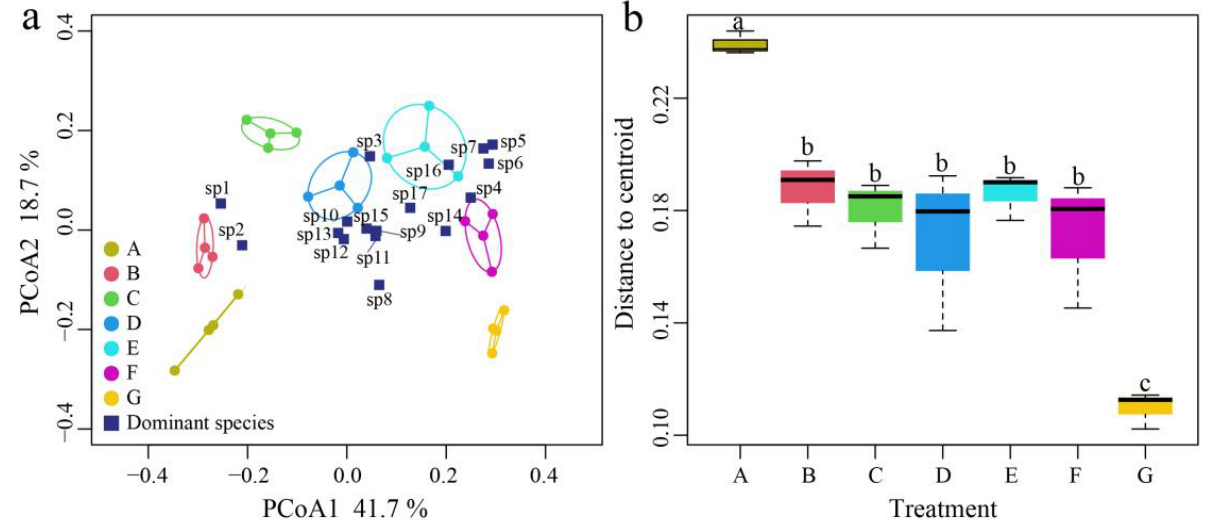
Figure 6. PcoA showed the differences in zooplankton community structure ( a ) and average dis- tance to the centroid ( b ) in the treatments of the nutrient addition experiment. Different letters rep- resent significant differences ( p < 0.05). sp1, Trichocerca stylata ; sp2, Colurella obtusa ; sp3, Polyarthra dolichoptera ; sp4, Brachionus falcatus ; sp5, B. urceus ; sp6, B. forficula ; sp7, B. angularis ; sp8, B. calyciflo- rus ; sp9, Thermocyclops taihokuensis ; sp10, T. vermifer ; sp11, T. hyalinus ; sp12, Mesocyclops leuckarti ; sp13, Daphnia carinata ; sp14, Scapholeberis aurita ; sp15, Simocephalus Vetulus ; sp16, Bosmina longiros- tris ; sp17, B. coregoni